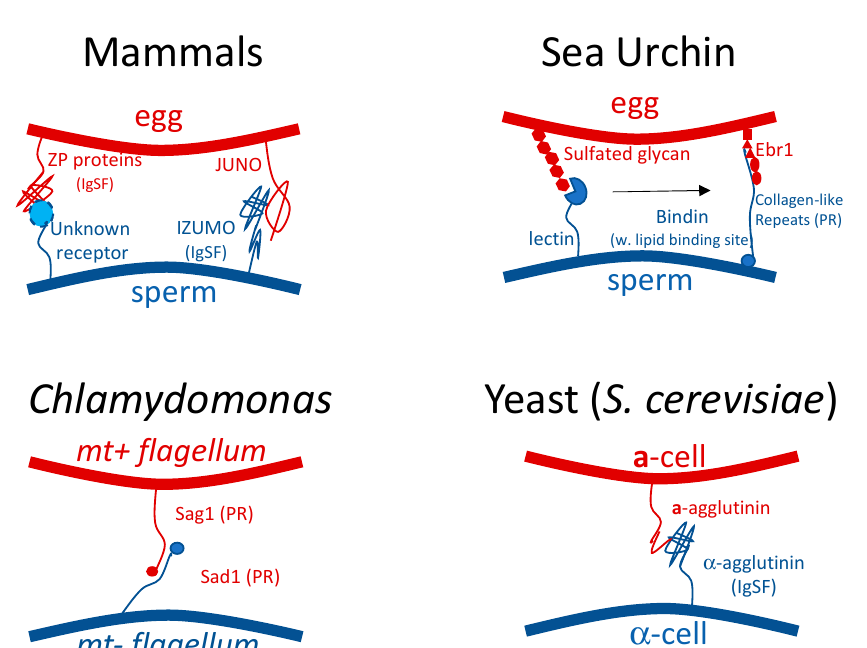
Figure 1. Cartoon models of some eukaryotic mating adhesins, as described in the text. Protein with Greek key β -sandwiches (IgSF) and Pro-rich repeats (PR) as recurring motifs.